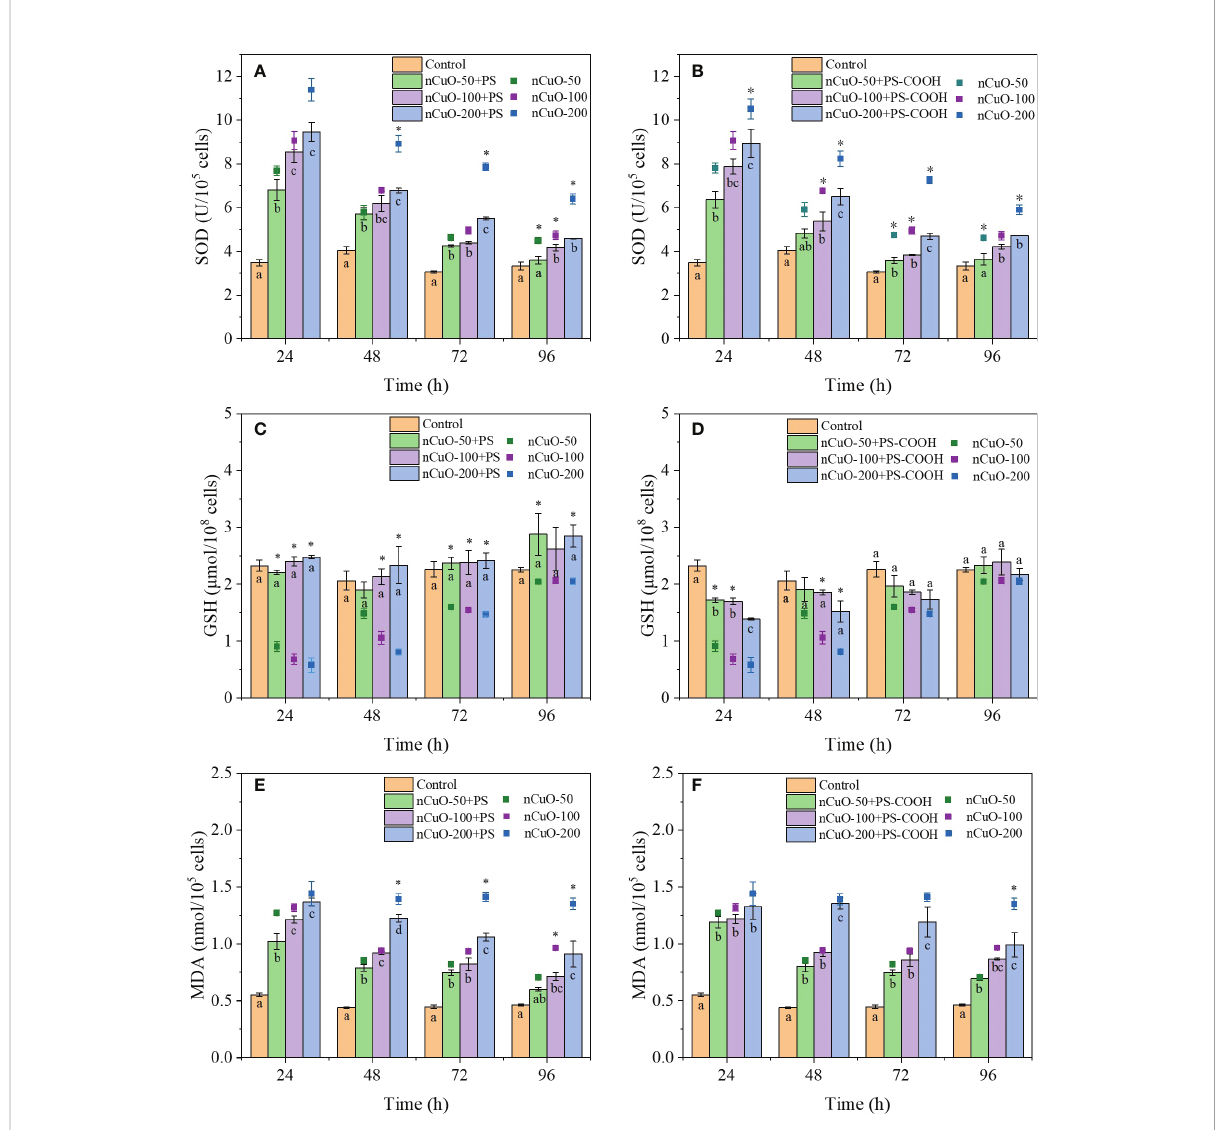
FIGURE 3 Combined effects of different concentrations of nCuO with 100mg/L PS and PS-COOH on SOD activity (A, B) , GSH content (C, D) and MDA content (E, F) in P. helgolandica var. tsingtaoensis . Error bars represent standard deviations (n = 3). Different letters indicate signi fi cant differences among the treatment groups (P < 0.05). Asterisks indicate signi fi cant differences between single nCuO groups and the combined groups (P <